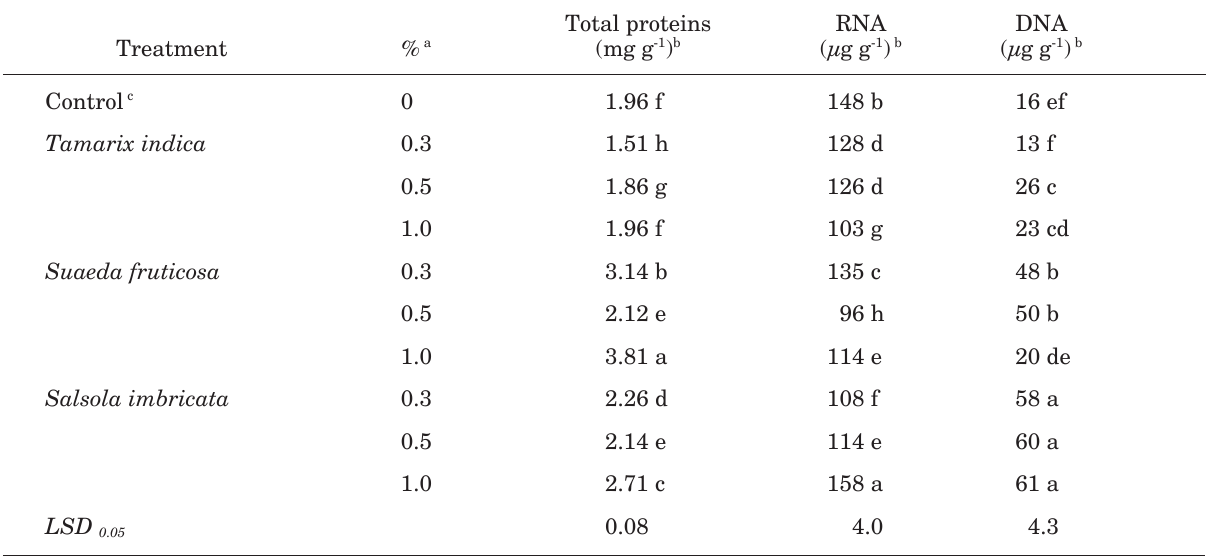
Table 7. Effect of three halophytes on total proteins and nucleic acid contents of okra infected with Meloidogyne ja- vanica